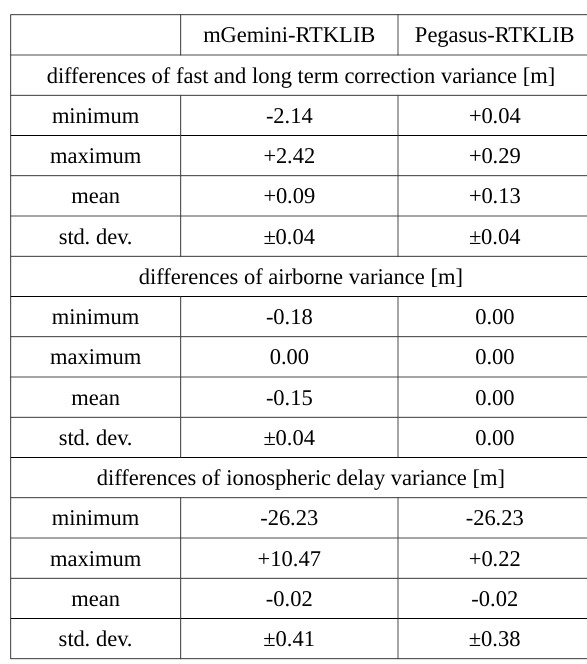
Table 3. Statistical parameters of differences in